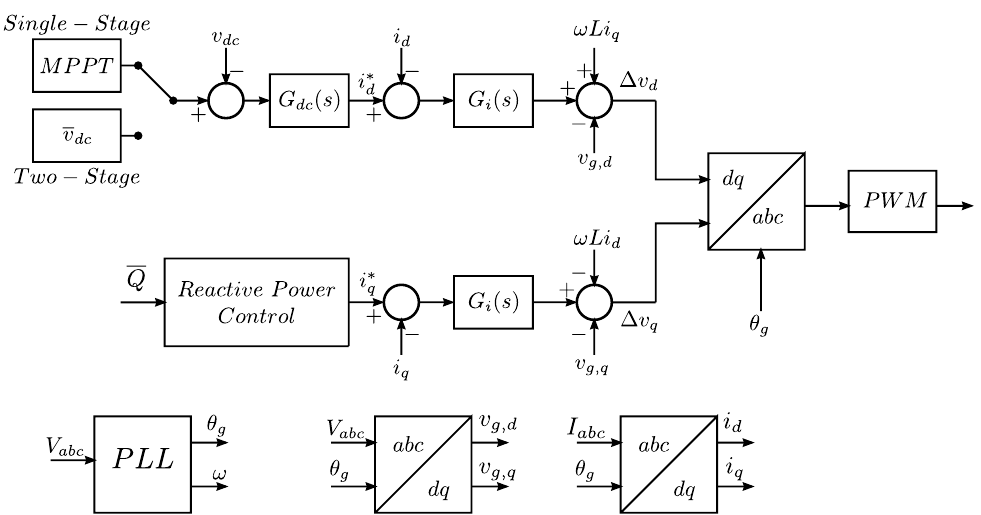
Figure 4. Block diagram of the DC/AC converter control in the dq frame.